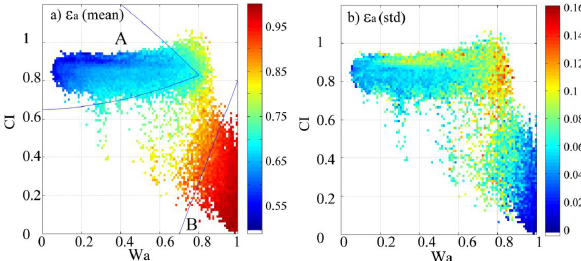
measurements as a function of CI and W a .